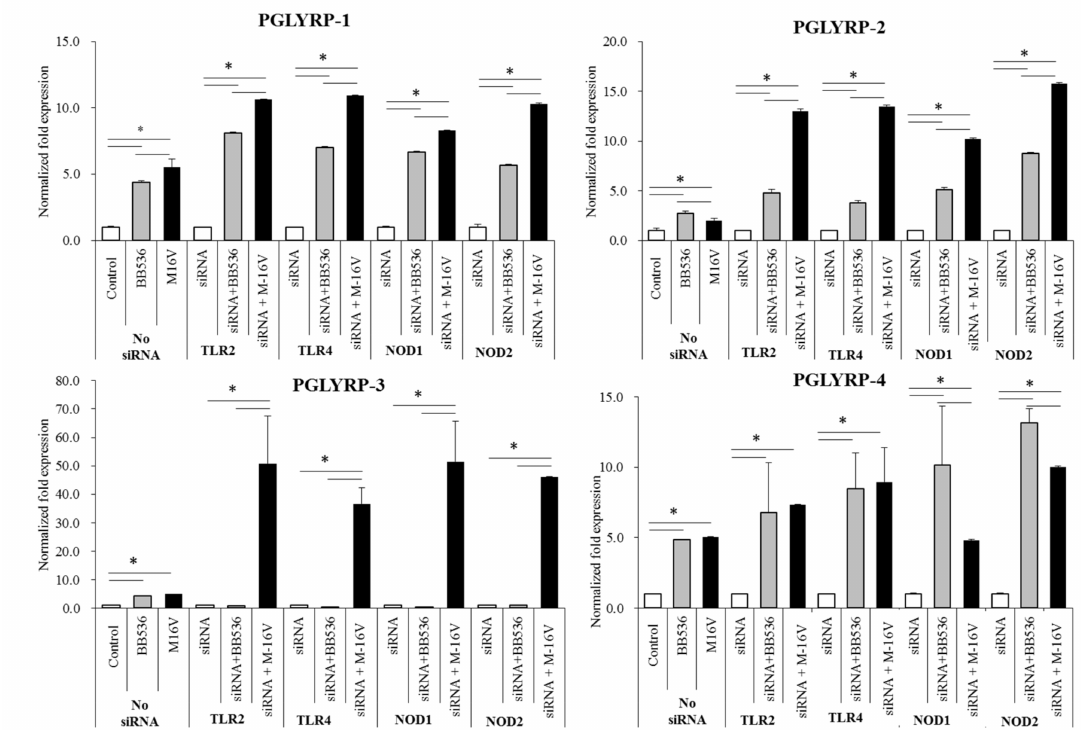
Figure 7. Paraimmunobiotic bifidobacteria-mediated peptidoglycan recognition proteins (PGLYRP) expressions in pattern recognition receptor (PRR)-knockdown porcine intestinal epithelial (PIE)